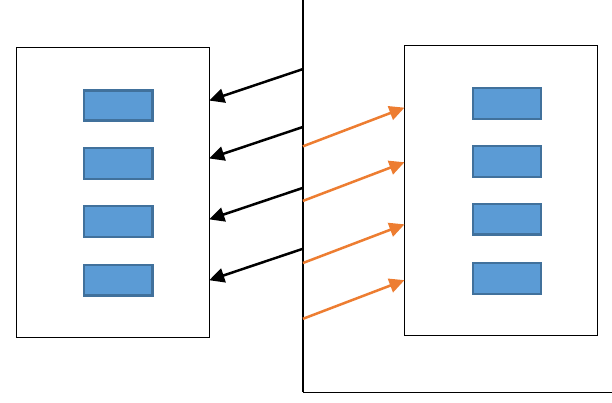
Figure 1. Customer